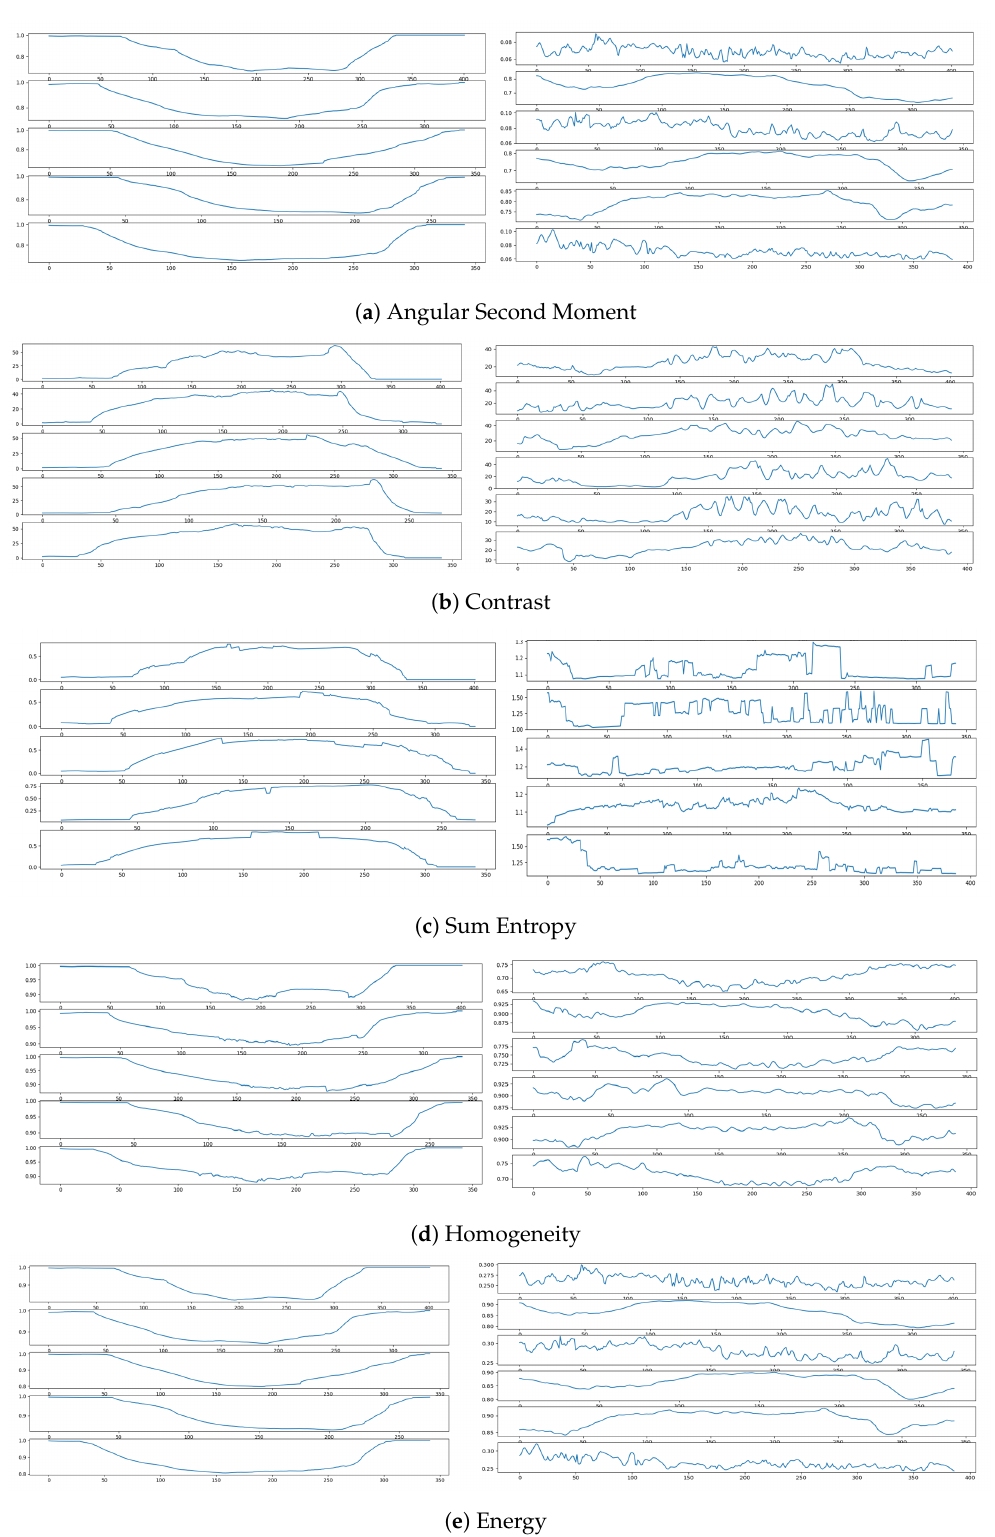
Figure 7. Haralick Textural Features extracted from lung tissue binary mask slices ( left ) and from full HU band CT slices ( right